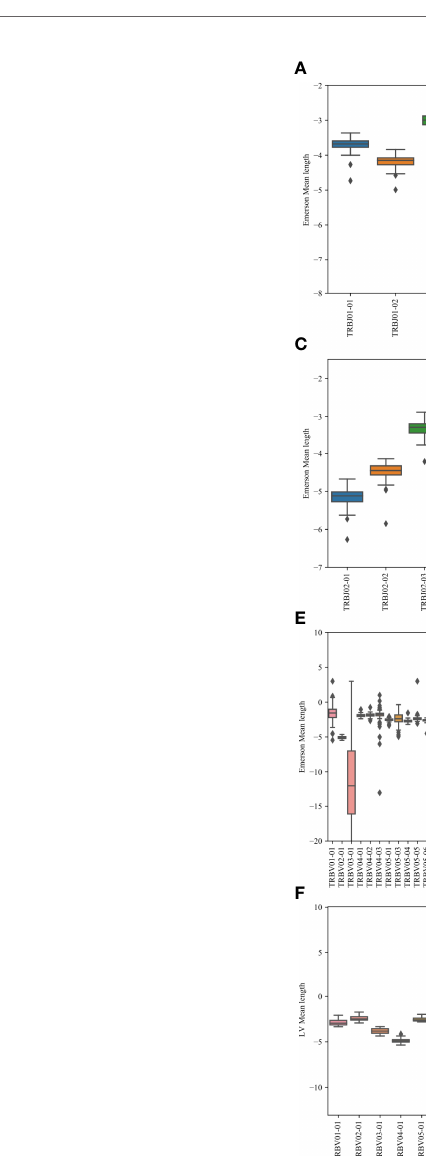
FIGURE 7 | Junction length. In the J b plots, the junction length is the average distance between the beginning of the germline J b gene, and the end of the germline D b gene. In the V b plot, the difference is between the V b germline and the D b germline genes. (A, B) The mean distance for the Emerson dataset (A) and for the LV dataset (B) . The x-axis represents the various J b genes within the J b 1 family gene. (C, D) The mean distance values for the Emerson dataset (C) and for the LV dataset (D) . The x-axis represents the various J b genes within the J b 2 family gene. (E, F) The mean distance values for the Emerson dataset (E) and for the LV dataset (F) . The x-axis represents the various V b genes within the J b 1 family gene. The interpretation of the boxes follows the previous